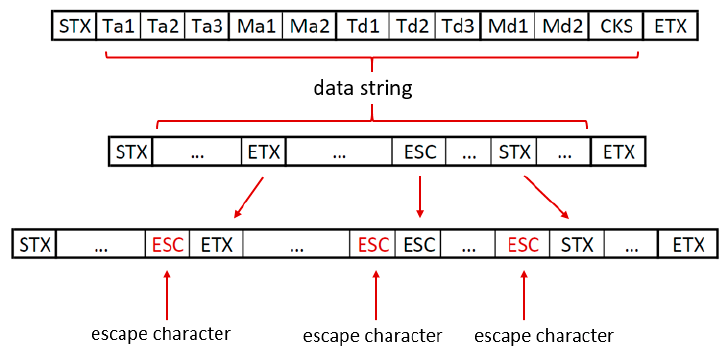
Figure 6. Example of byte stuffing on a data string containing three data bytes that coincide with the special characters.